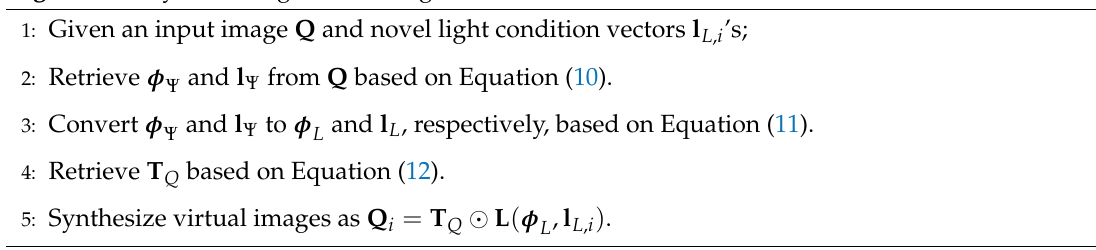
Algorithm 2 Synthesizing virtual